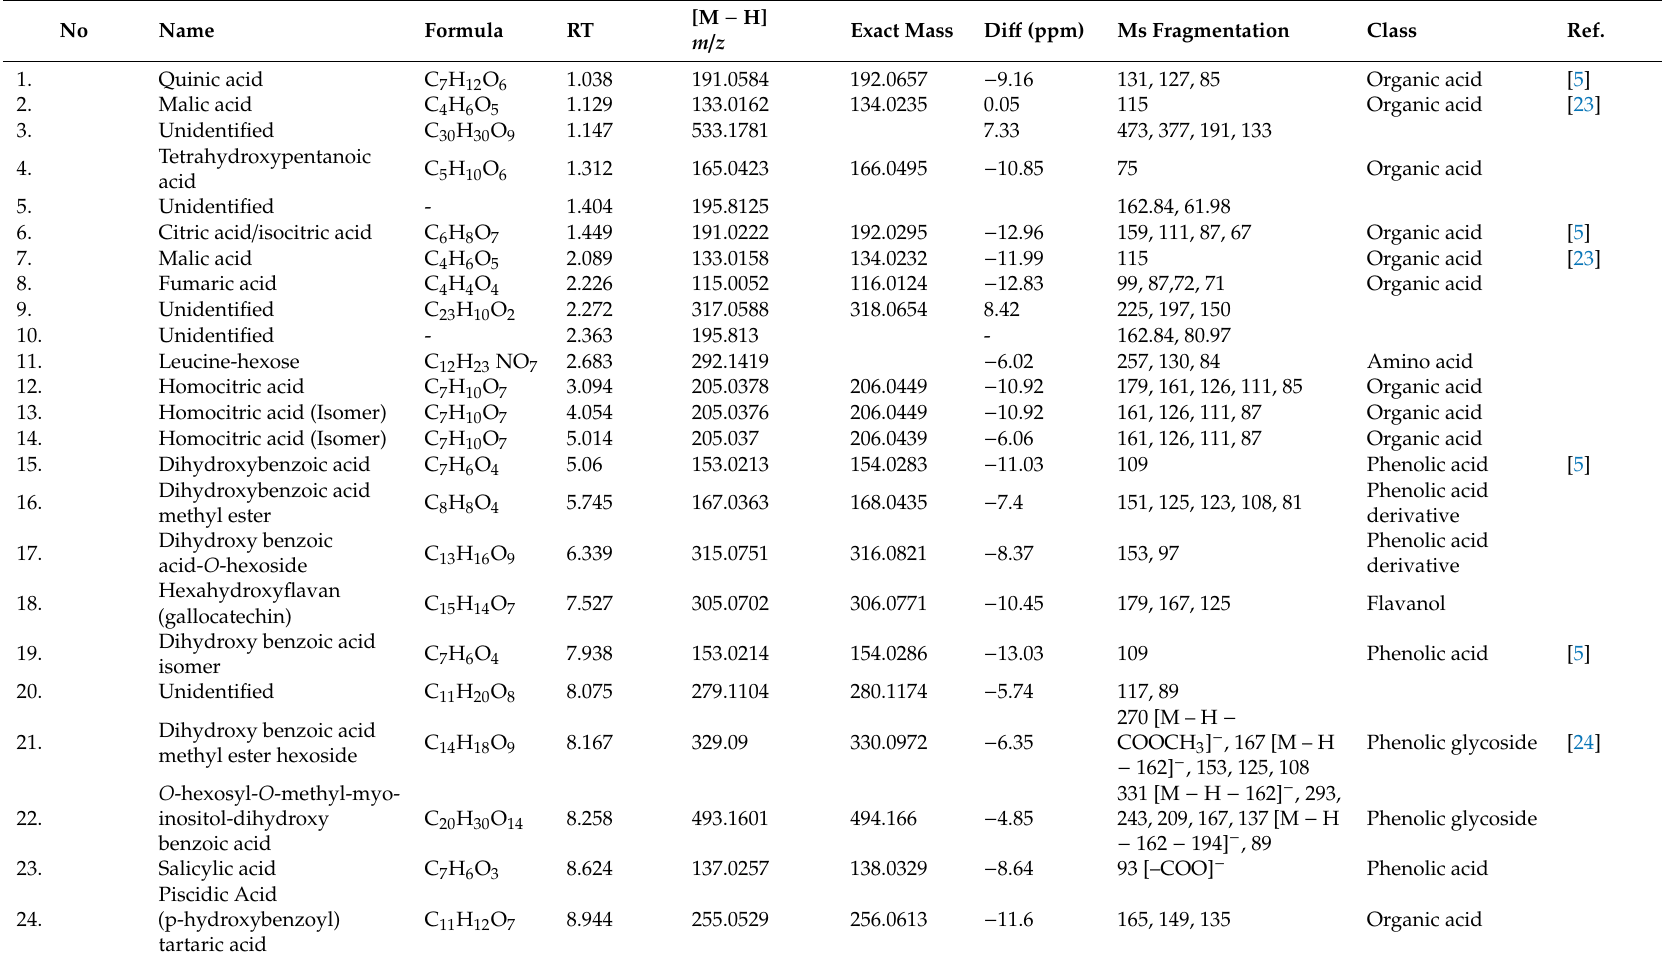
Table 1. Identified metabolites in C. conglomeratus alcoholic extract via